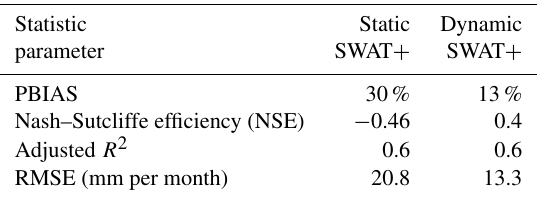
Table 2. Statistical analysis of ET comparison of SWAT scenarios from remote